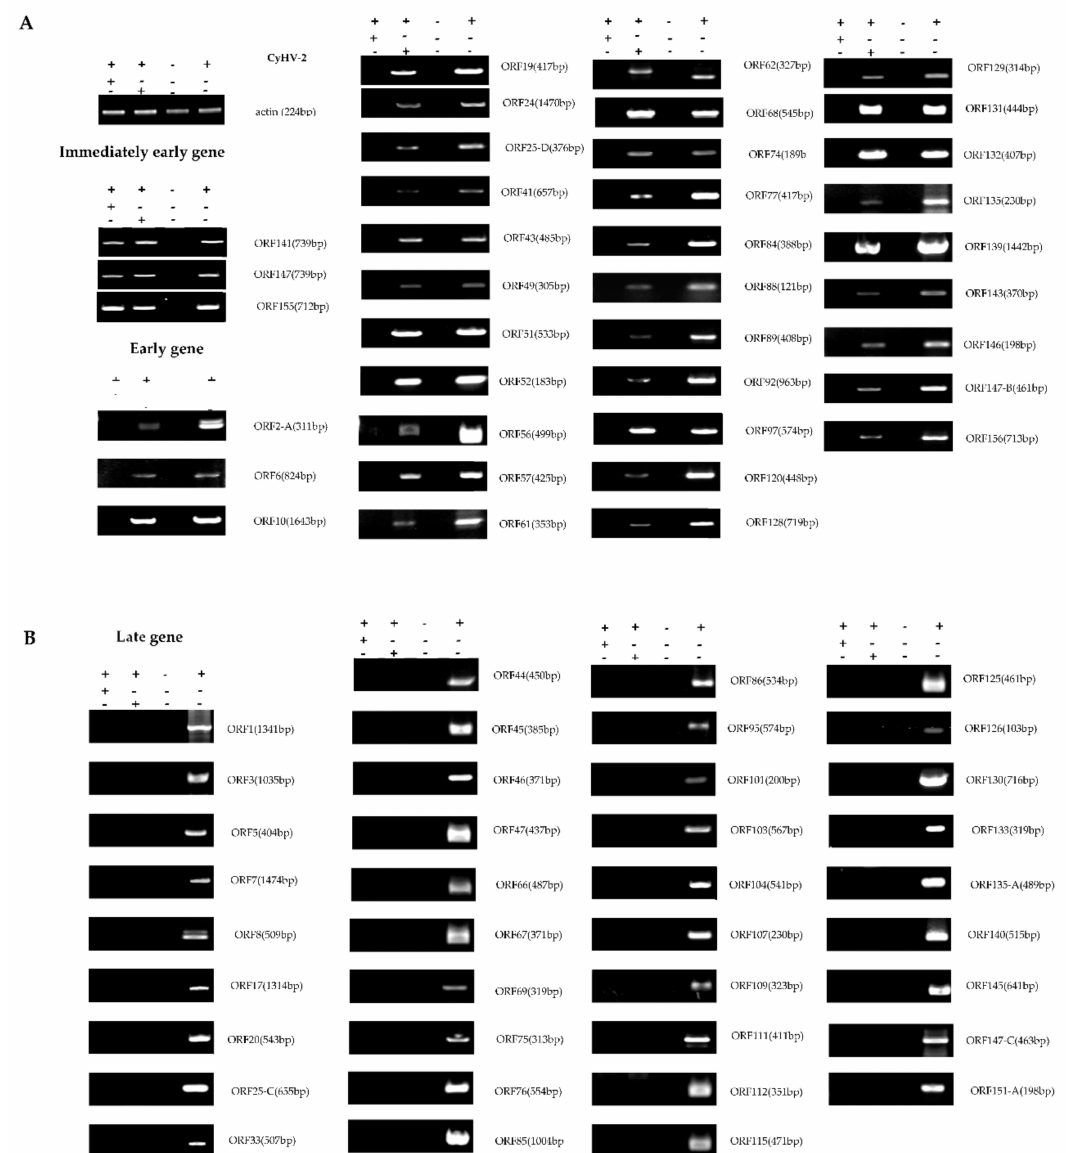
Figure 7. Classification of gene expression distinct phases of CyHV-2 base on inhibitors treatment. According to the transcriptome results, the gene expression in di ff erent inhibitor treatment groups were validated by RT-PCR. Specific primers for di ff erent ORFs were designed to detect CyHV-2 gene expression and classify the phases of CyHV-2 gene expression. CHX can inhibit the expression of genes other than the early genes of the virus by inhibiting protein synthesis. Early gene expression cannot be suppressed by Ara-C. The gene encoding actin was used as an internal reference. ( A ) Immediate-early and early genes; ( B ) Late genes. CHX: “ + ” treated with 12 µ g / mL CHX, “-” without CHX; Ara-C: “ + ” treated with 300 µ g / mL Ara-C, “ − ” without Ara-C; CyHV-2: “ + ” infected with CyHV-2; “ − ”